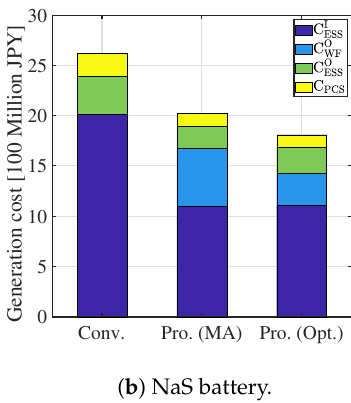
Figure 18. Average cost.